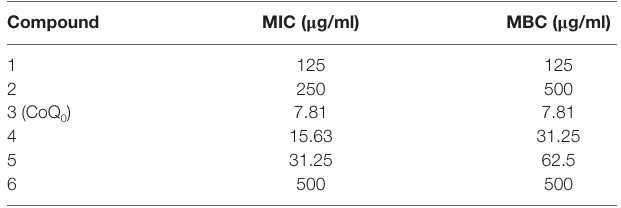
MRSA killing at CoQ concentrations of ≤78 μg/ml. The survival 0 rate of 156 and 312 μg/ml was 63% and 0%, respectively. Visual obtained using fluorescence microscopy. In Figure 1F , the green signal stained by SYTO9 represents live MRSA, whereas the red fluorescence stained by propidium iodide (PI) indicates bacterial membrane disruption resulting in a diffuse distribution in the cytoplasm. The green dots decreased following the increase of the CoQ concentration. However, the red dots were limited, 0 although the concentration was significantly increased.